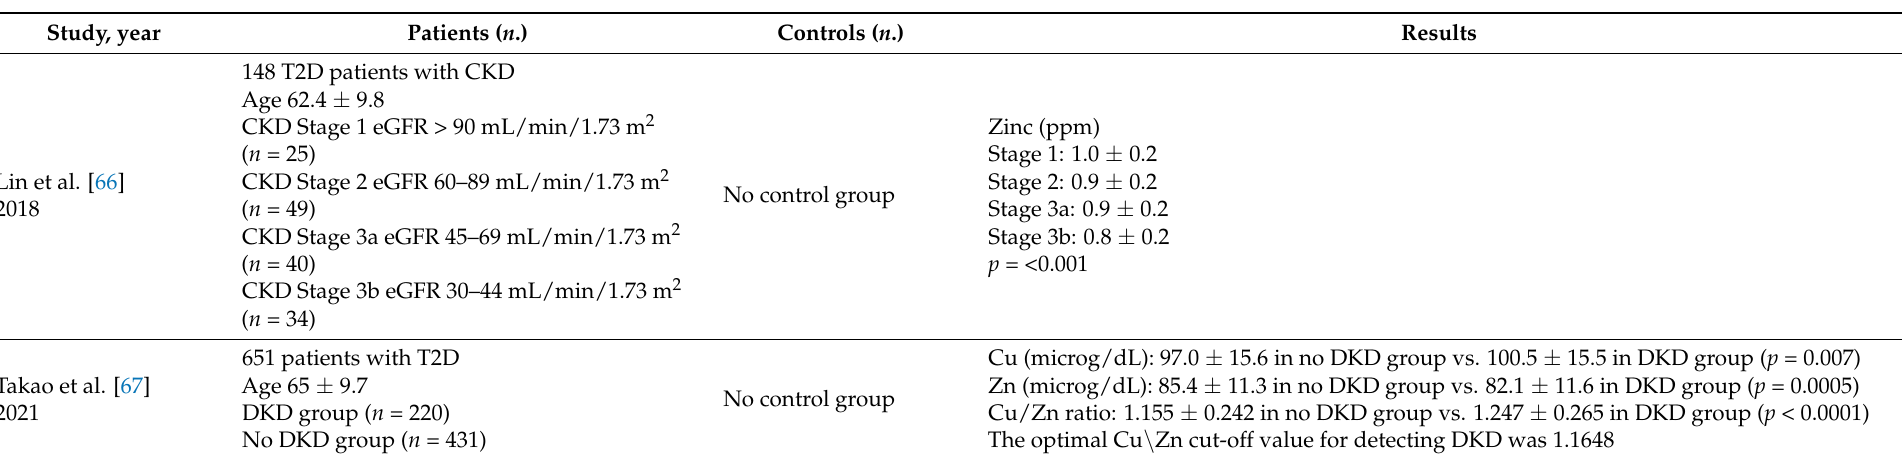
Table 2. Randomized-Controlled Trials analyzing zinc serum levels and renal impairment progression in DKD. Abbreviations: NAG, N-Acetyl- β